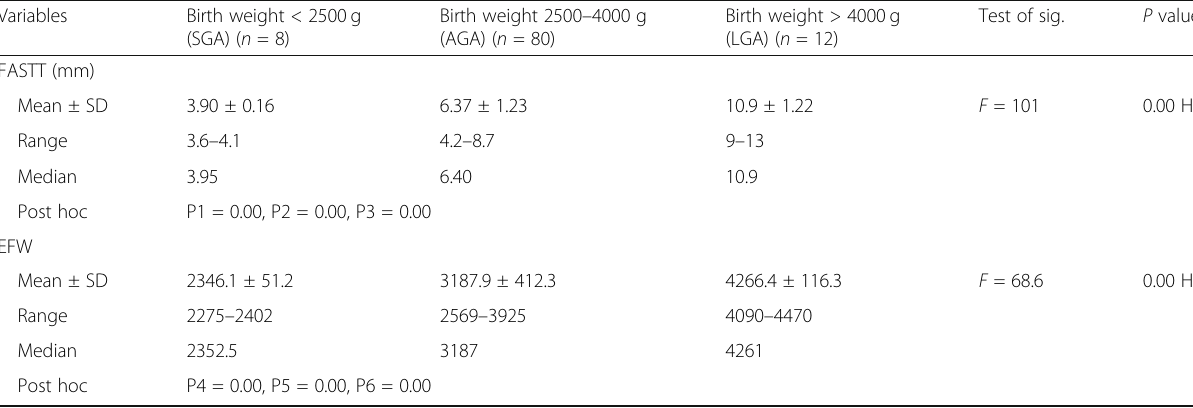
Table 2 Birth weight groups and sonographic fetal weight of studied pregnant women Variables